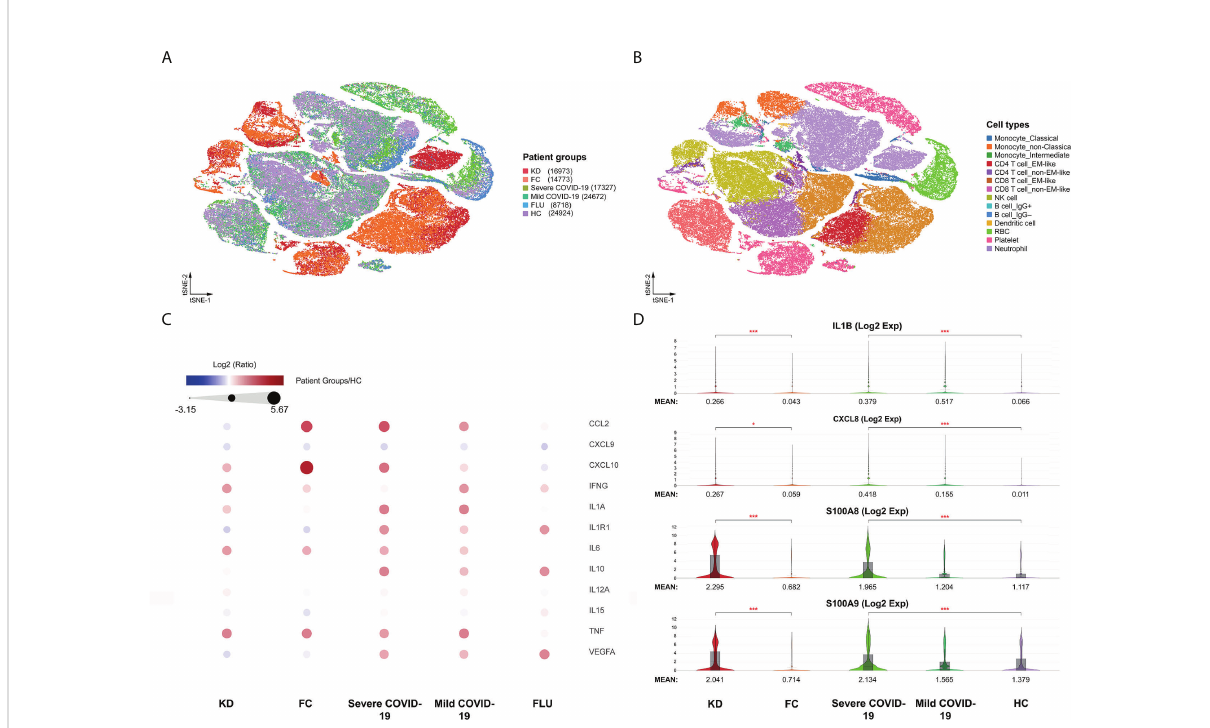
FIGURE 1 Immunological characterization of blood cells from Kawasaki disease and COVID-19 patients. (A) t-SNE projection of the blood cells from patients with Kawasaki disease (KD) (three samples), febrile controls (FC) (two samples), patients with COVID-19 (four samples for mild COVID- 19, fi ve samples for severe COVID-19), and healthy controls (HC) (four samples). Each dot corresponds to a single cell, colored according to group information. (B) t-SNE projection colored by cell types. Canonical cell markers were used to label clusters by cell identity as represented in the t-SNE plots of Figure S1. (C) Direct comparison of known cytokines among single-cell datasets that may be involved in hypercytokinemia of both KD and severe COVID-19 diseases. (D) Violin plots showing the comparable expression of canonical hypercytokinemia markers IL1B, CXCL8, S100A8, and S100A9 under different conditions. Genes were considered differentially expressed according to the P values from the Mann-Whitney U test with a false discovery rate (FDR) < 0.05 (*), or < 0.0005